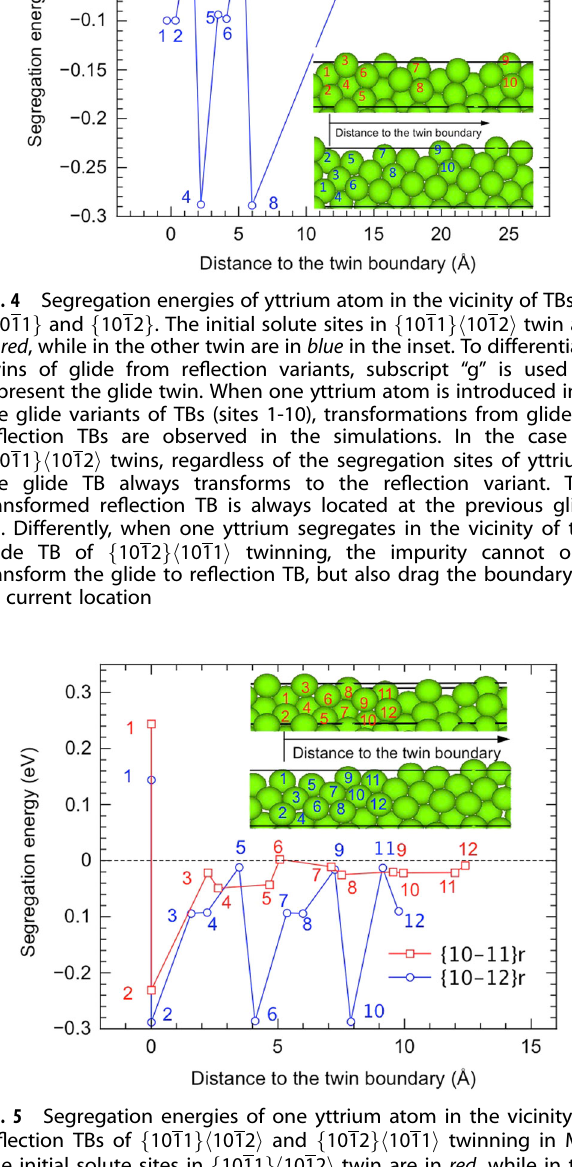
Fig. 4. The relaxed atomic structures indicate transformations from glide TBs to re fl ection TBs are spontaneously triggered in both glide twins on f 10 11 g and f 1012 g . Differently, when one yttrium